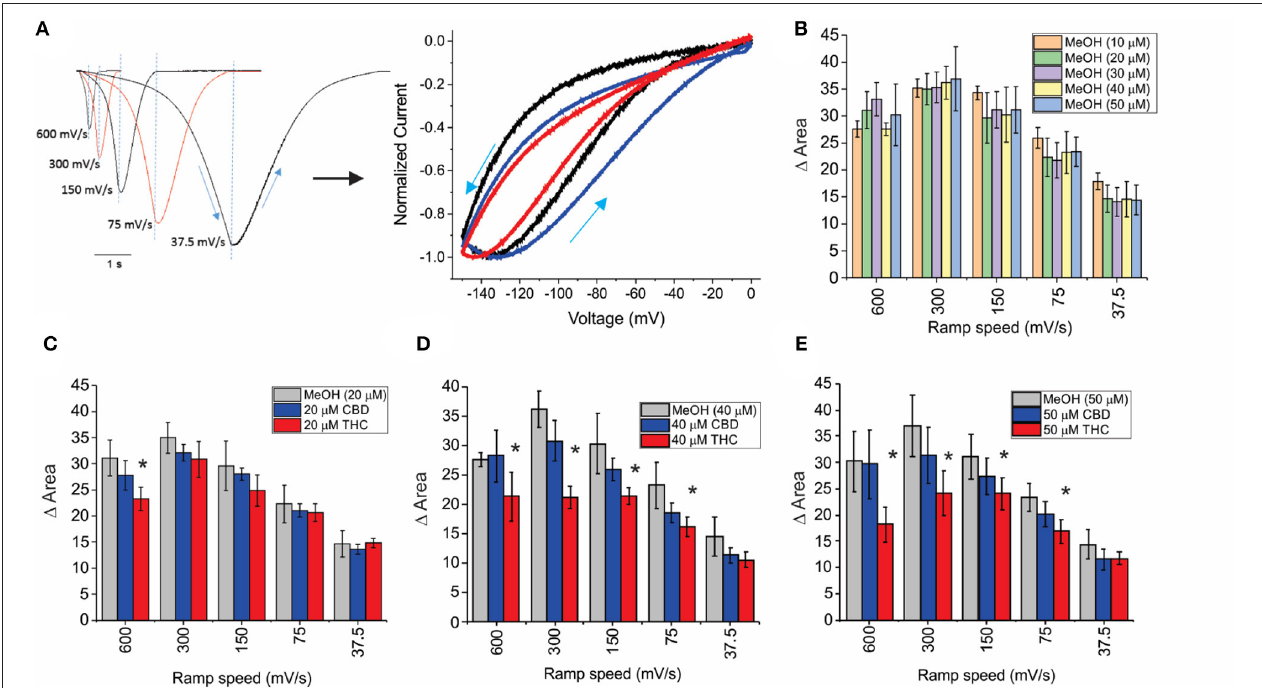
FIGURE 4 | Effects of CBD and THC on HCN1 hysteresis. (A) Ramps from 0 to − 150mV and back to 0mV at speeds of 600, 300, 150, 75, and 37.5 mV/s. The degree of hysteresis was quantified by the area between the forward and backward current traces when plotted vs. the membrane voltage. (B) Histogram of HCN1 hysteresis for HCN1 treated with different concentrations of methanol used as vehicles for the cannabinoids at concentrations listed in parentheses. Hysteresis is unaffected by increasing concentrations of methanol. (C–E) THC reduces the degree of hysteresis at fast ramp speeds, with a greater range of ramp speeds affected as THC concentration increases. CBD did not affect HCN1 hysteresis (3 < n < 10 for each condition; * P <